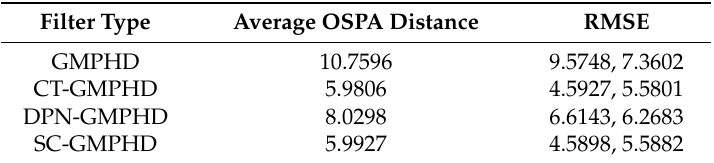
Table 5. Average OSPA distance and running time of the different filters with different clutter rates Table 4. Average OSPA distance and RMSE comparison of the four filters for a target on a curved road. when the detection probability is equal to 0.9.